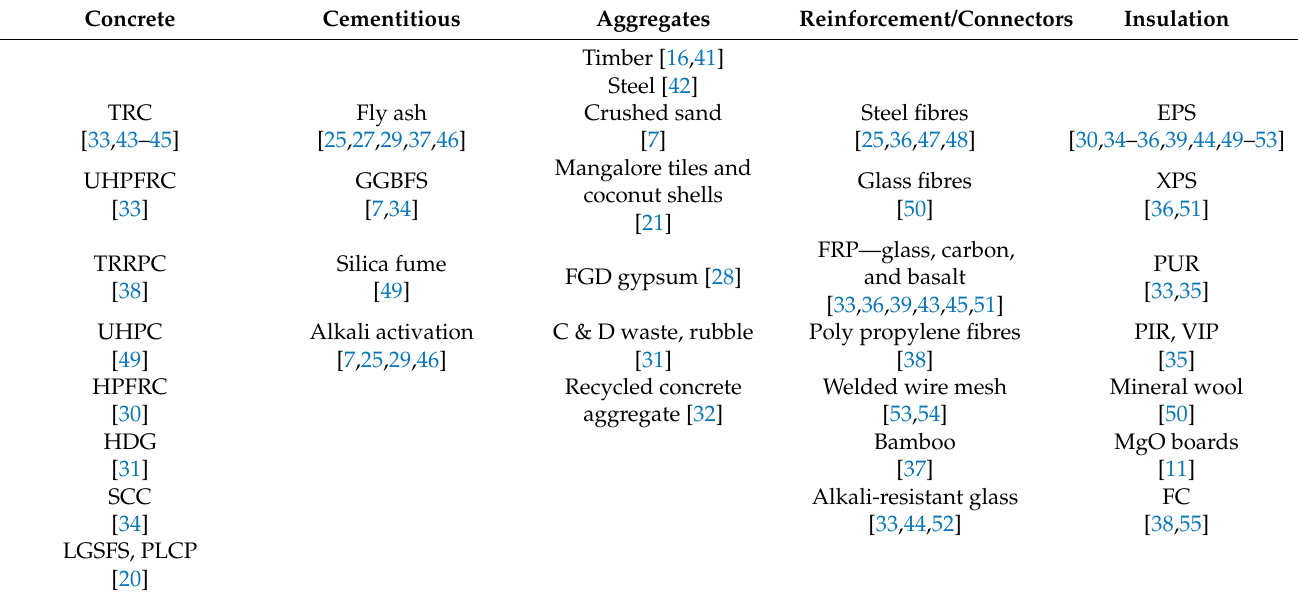
Table 3. Variety of materials used in prefabrication over the